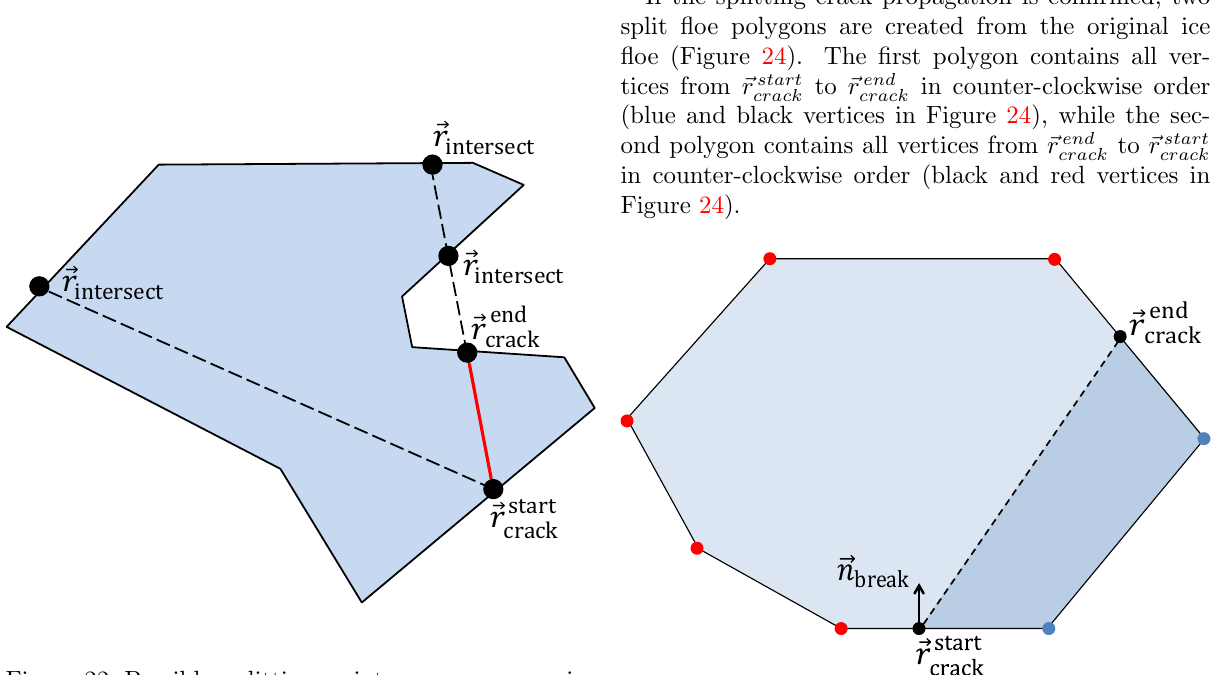
Figure 22: Possible splitting points on a concave ice floe polygon and the eventually selected splitting crack (red).